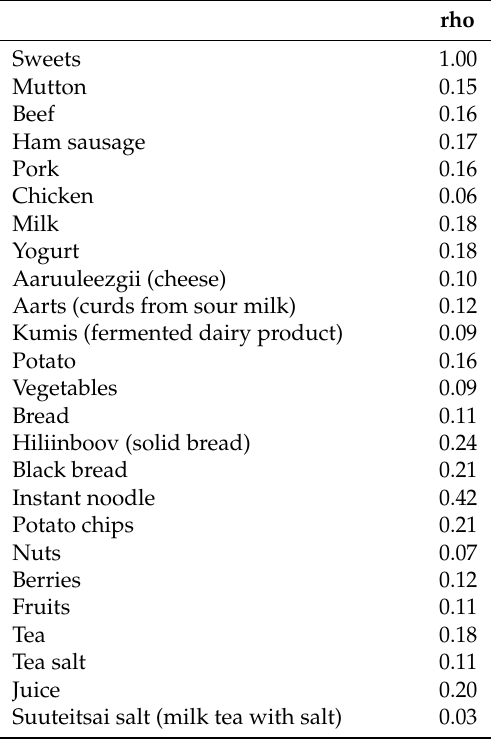
Table A1. Pearson’s correlation coe ffi cients between various foods and sweets consumed by students in the past